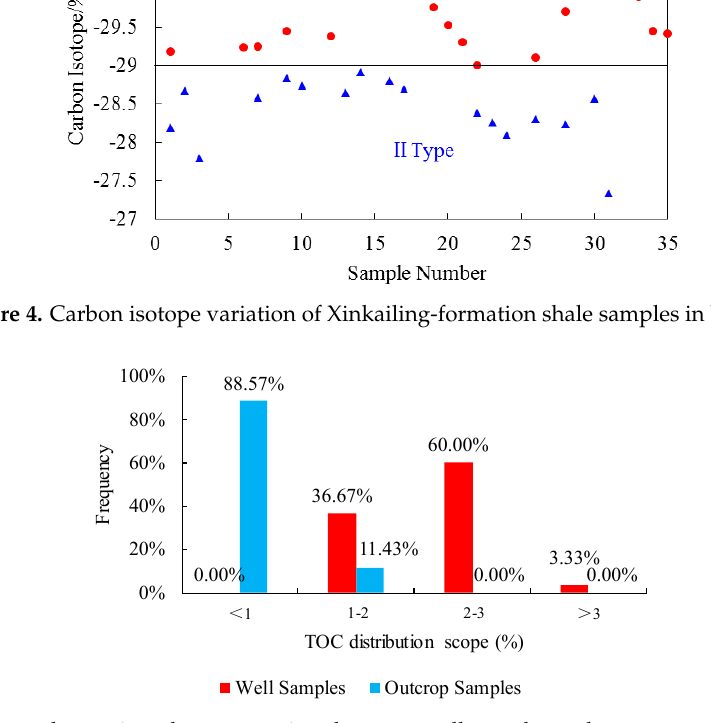
Figure 5. The total organic carbon comparison between well samples and outcrop samples in Wuning.